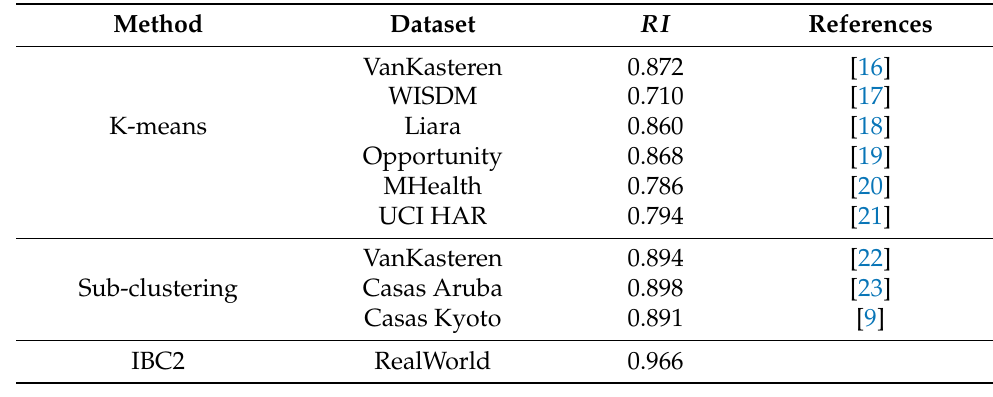
Table 10. Comparing